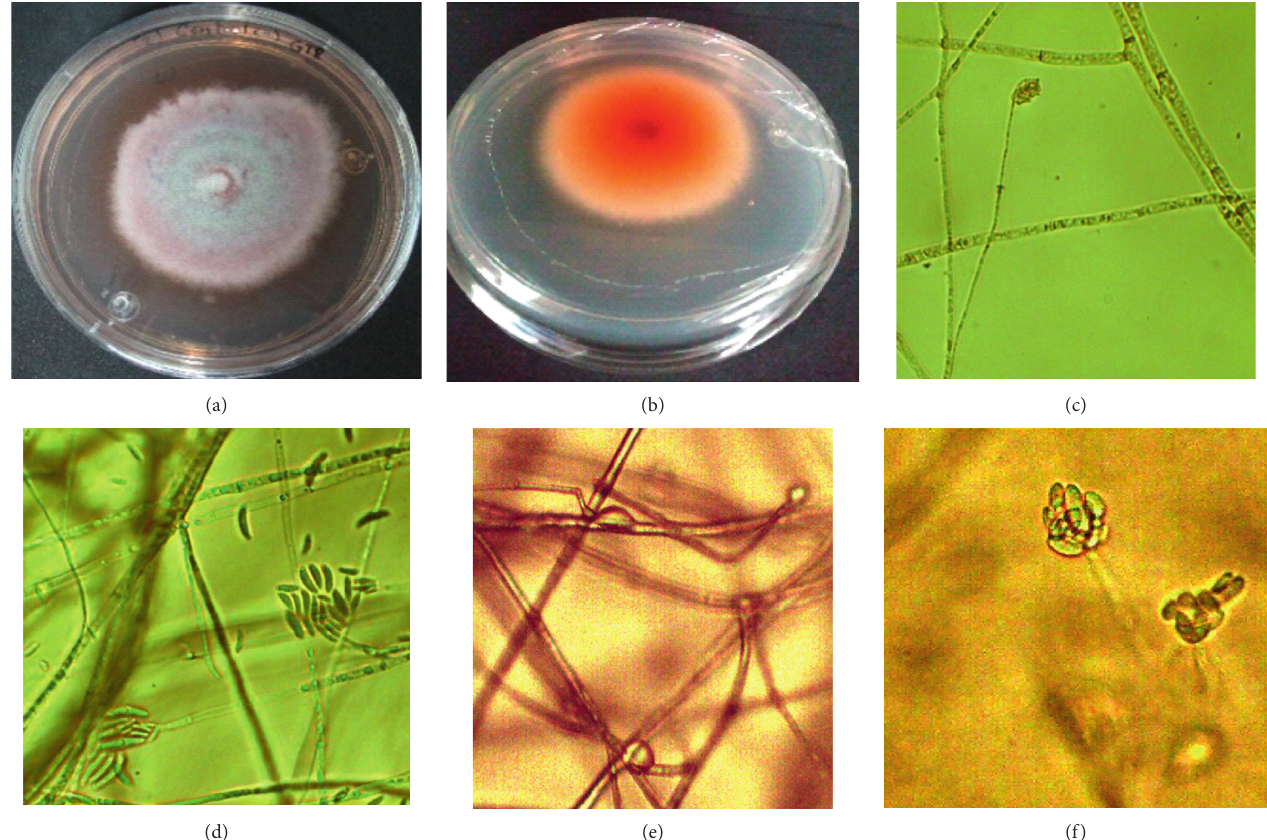
Figure 2: Nectria haematococca : (a) Front plate. (b) Reverse plate. (c) Mycelium. (d) Macroconidia. (e) Microconidia. (f) Conidiophore.